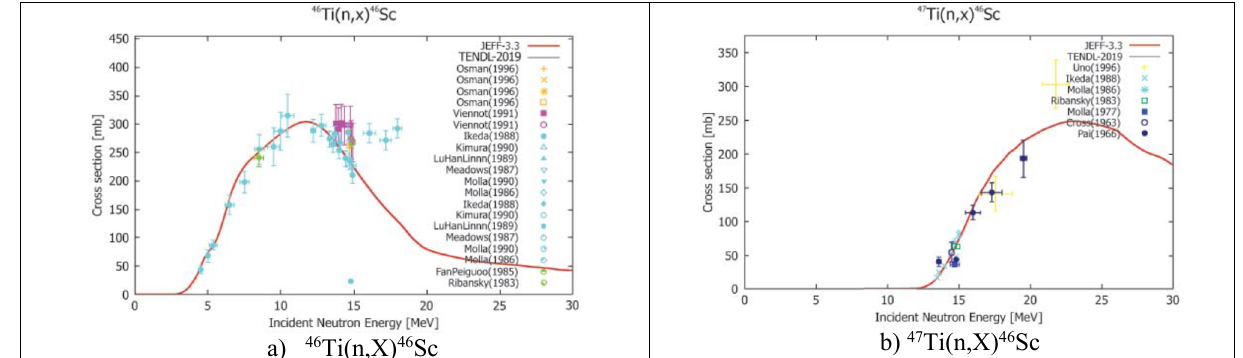
Fig. 2. Experimental data for the nat Ti(n,X) 46 Sc cross section from the separate titanium isotopes